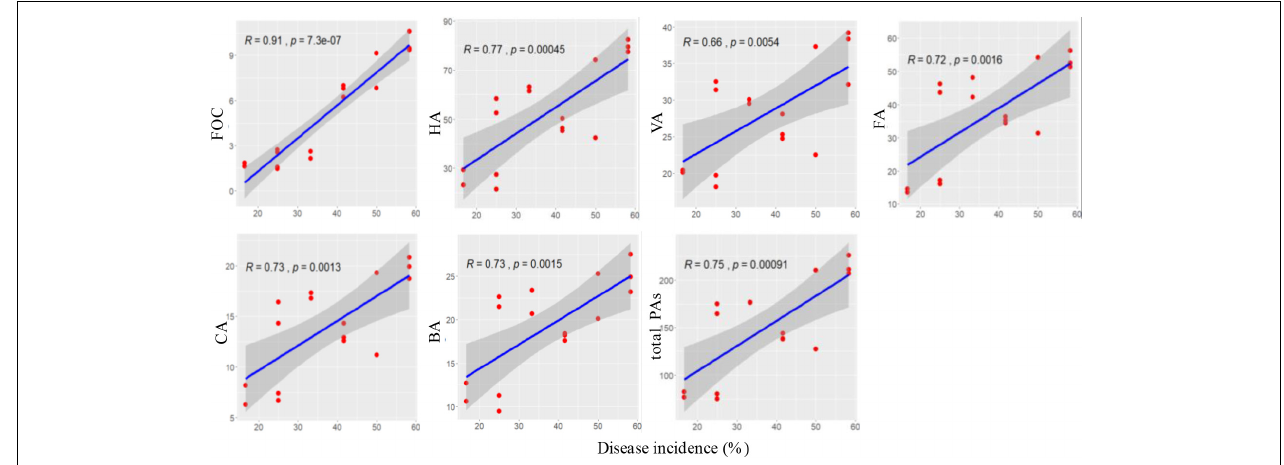
FIGURE 9 | Correlations between Fusarium wilt disease incidence and soil FOC and phenolic acids at 60 days after transplanting.